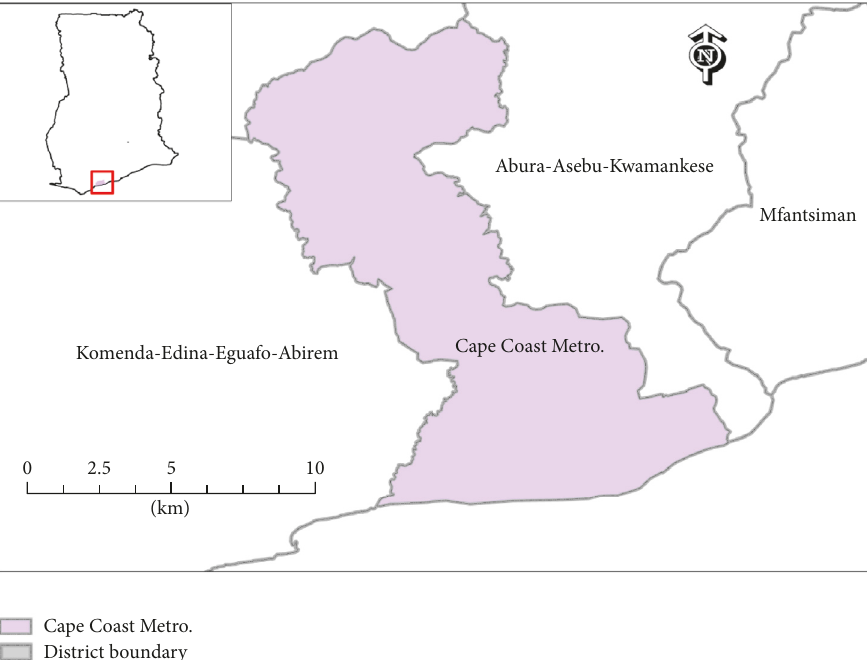
Figure 1: Map of Cape Coast Metropolitan Area (credit: Dr. Charles Gyamfi, Department of Civil Engineering, Tshwane University of Technology, Pretoria, South Africa)